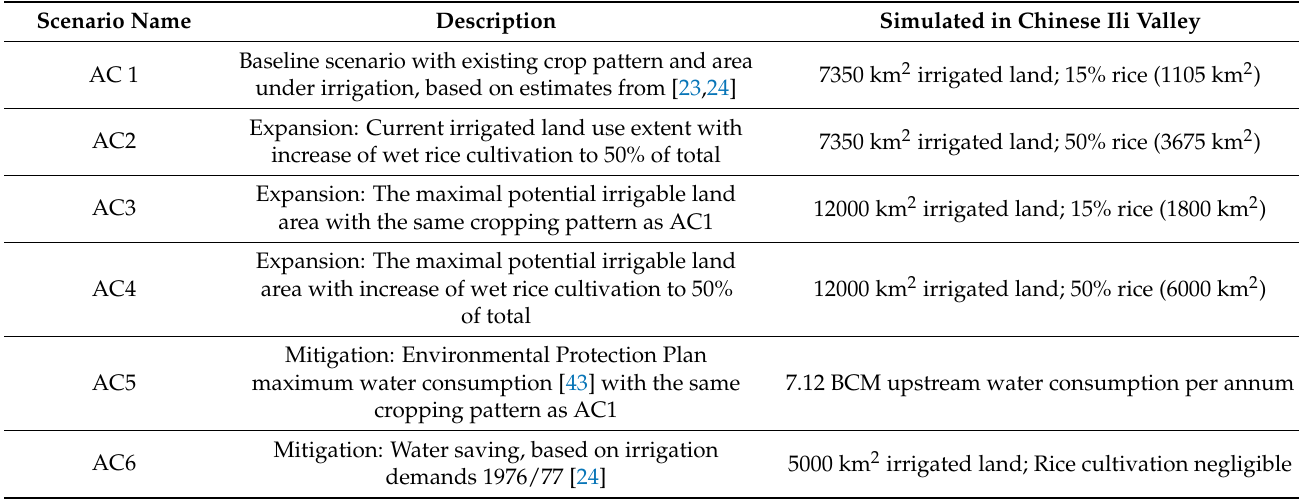
Table 3. Upstream irrigation water demand